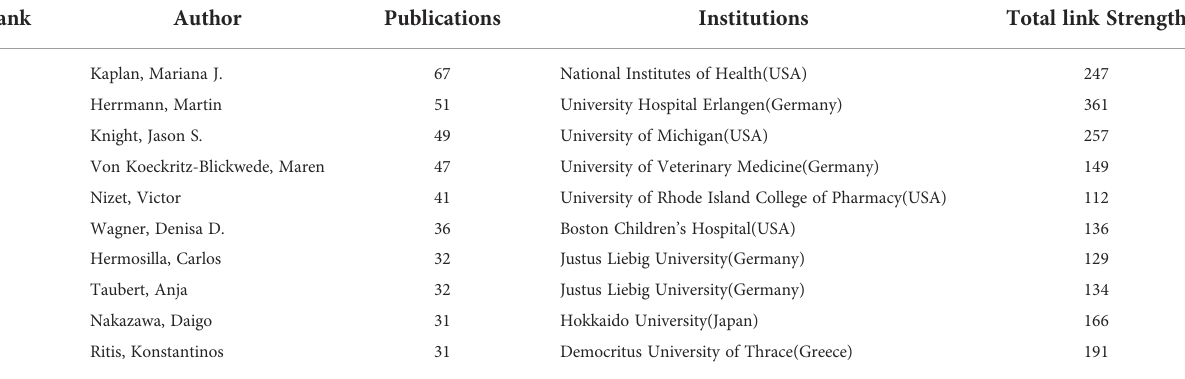
TABLE 3 Top 10 authors in terms of number of publications, the corresponding institutions and total link